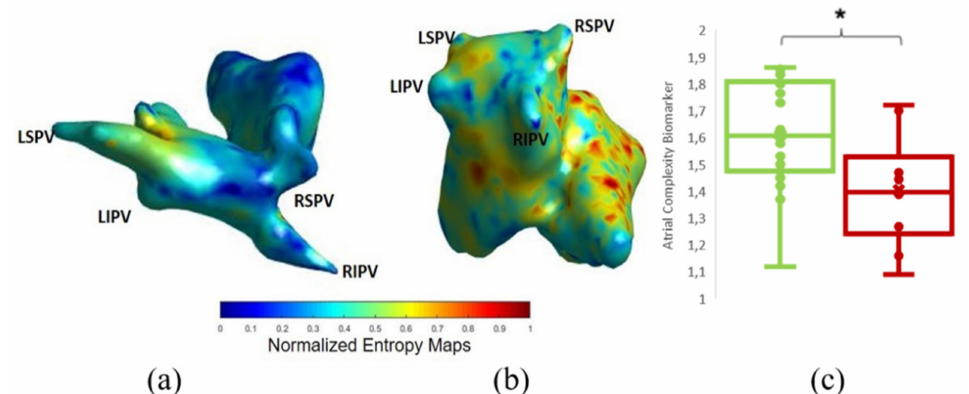
Figure 4. Example of normalized entropy maps for ( a ) Successful and ( b ) Unsuccessful ablation. ( a ) shows higher entropy on the pulmonary vein area while ( b ) shows a more diffused distribution of high entropy areas. ( c ) showed the ACM or mean number of rotors in simulations around the pulmonary vein area for AF freedom (green) and AF cases (red). * p <